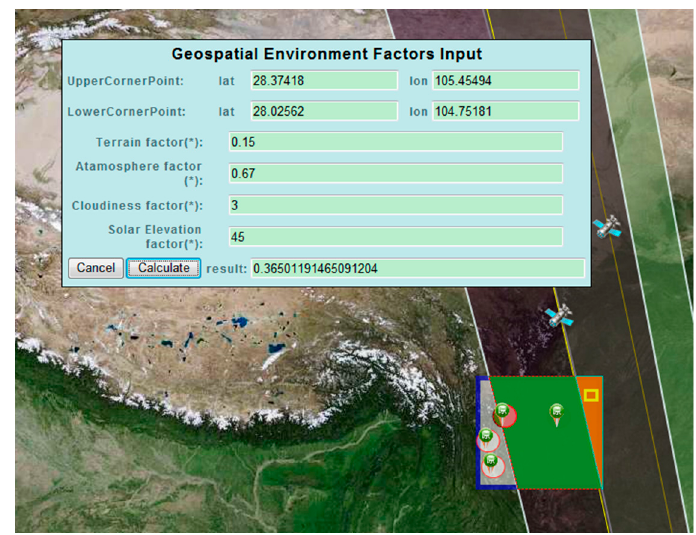
Figure 12. Geospatial environmental features inputted for the observation quality calculation.